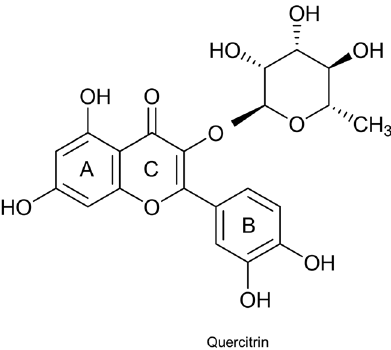
Figure 1: The molecular structure formula